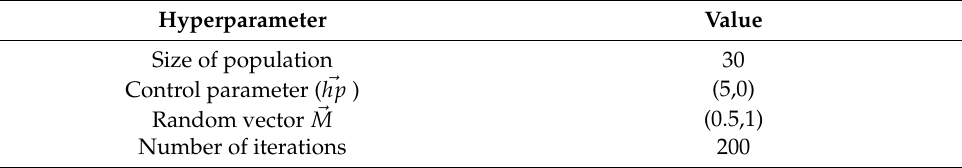
Table 3. Parameters of